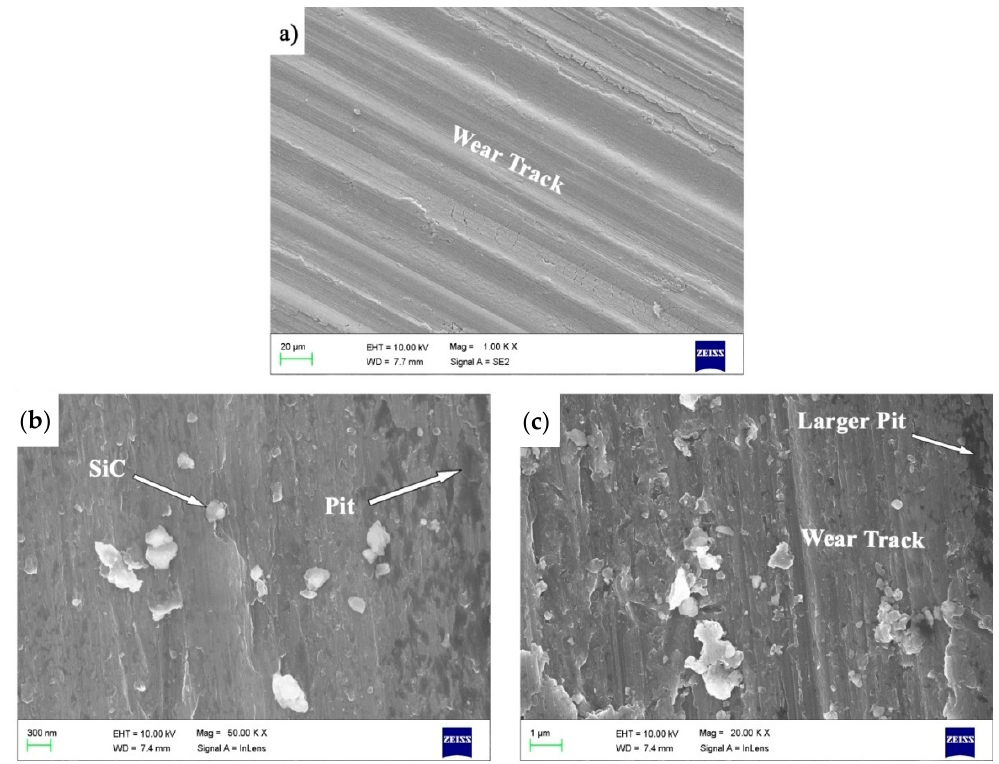
Figure 12. FESEM micrographs of the worn surfaces of the FSSW joints: ( a ) AA5058, ( b ) AA5083/nano-SiC, and ( c ) AA5083/micro-SiC.